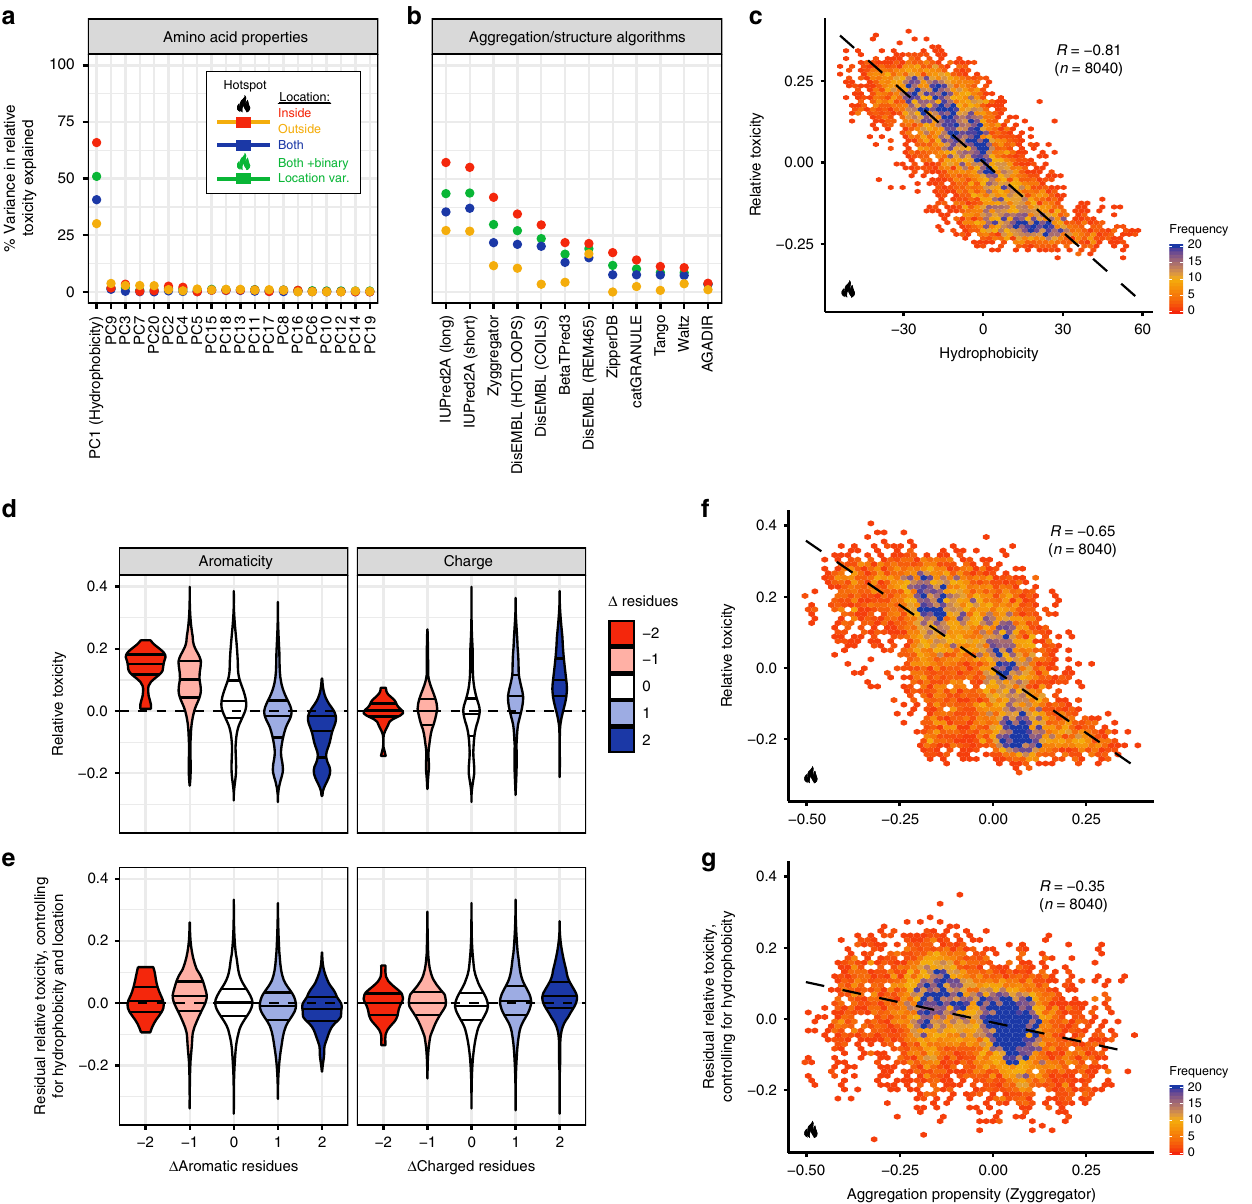
Fig. 2 Changes in hydrophobicity are highly predictive of TDP-43 cellular toxicity. a Percentage variance of toxicity explained by linear regression models predicting single and double mutant variant toxicity from changes in AA properties upon mutation (PCs, principal components of a collection of AA physico-chemical properties). Different regression models were built for different subsets of the data. Simple linear regression models for all variants (blue) or only variants inside (red) or outside (yellow) the hotspot region. And a regression model using all variants and including a binary location variable (inside/outside hotspot) as well as an interaction term between binary location variable and the indicated AA property feature (green). b Percentage variance of toxicity explained by linear regression models predicting variant toxicity using scores from aggregation/structure algorithms (see Methods). Colour key shown in panel ( a ). See also Supplementary Fig. 4. c Toxicity of variants with single or double mutations within the hotspot region as a function of hydrophobicity changes (PC1) induced by mutation. The Pearson correlation (R) before binning is indicated. See also Supplementary Fig. 9a. d Toxicity distributions of single and double mutants strati fi ed by the change in the number of aromatic (H,F,W,Y,V) or charged residues (R,D,E,K) relative to the WT sequence. Horizontal axis as in panel ( e ). e Distribution of residual toxicity after controlling for the effect of hydrophobicity and location on toxicity (green regression model in panel a) strati fi ed by the number of aromatic (H,F,W,Y,V) or charged (R,D,E,K) AAs. f Single and double mutant variant toxicity as a function of changes in aggregation propensity (Zyggregator). Only variants occurring within the toxicity hotspot are depicted. The Pearson correlation (R) before binning is indicated. g Toxicity as a function of aggregation propensity after controlling for hydrophobicity (red regression model in panel a). Only variants occurring within the toxicity hotspot are depicted. The Pearson correlation (R) before binning is indicated. See also Supplementary Fig.